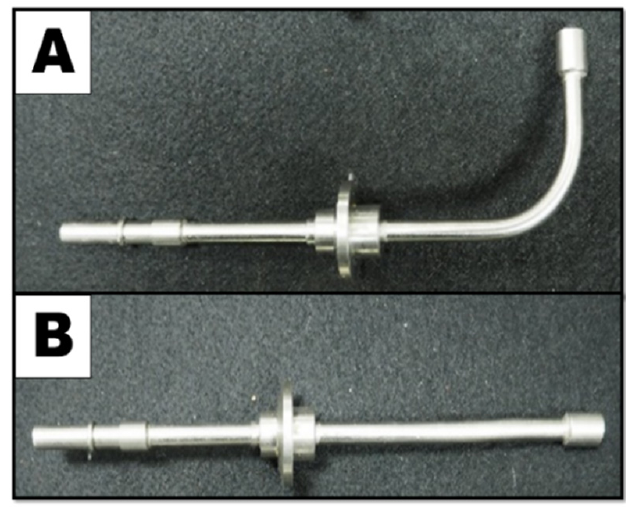
Figure 12. The urea injectors: ( A ) L-type (original type) and ( B ) I-type (improved type). Catalysts 2020 , 10 , x FOR PEER REVIEW